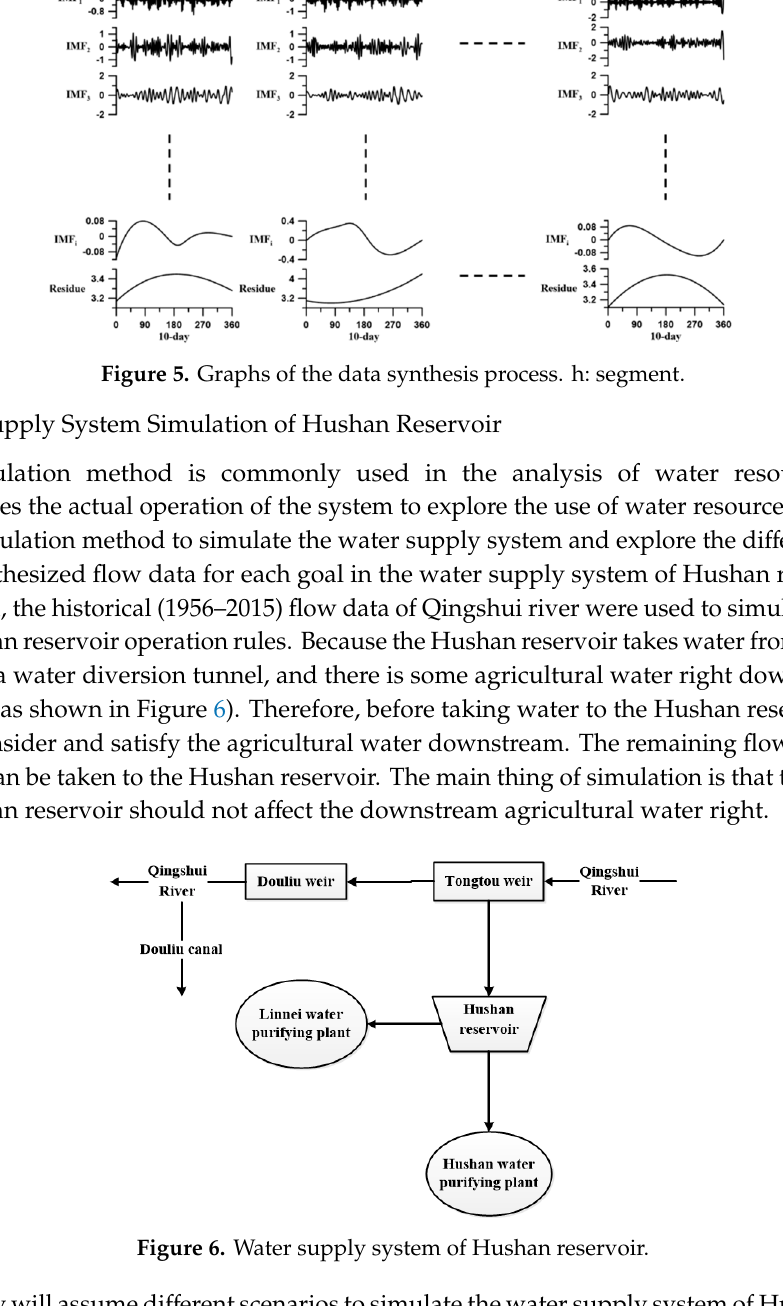
Figure 6. Water supply system of Hushan reservoir.